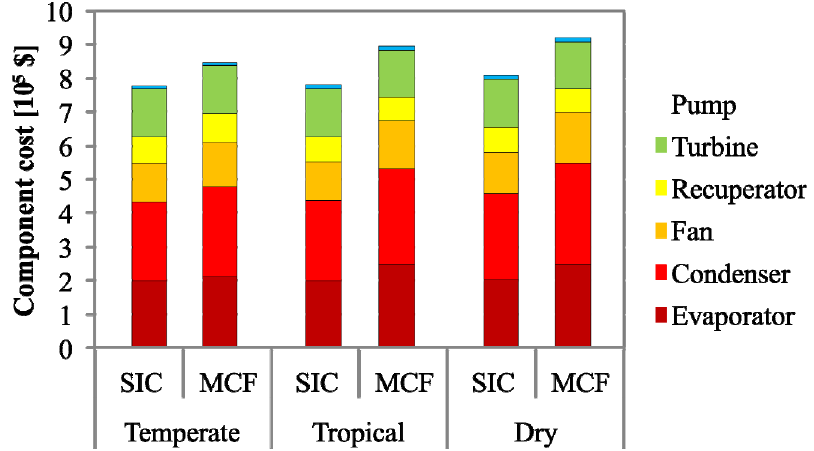
Figure 10. Relative component cost comparison between SIC and MCF optimization under three different climate